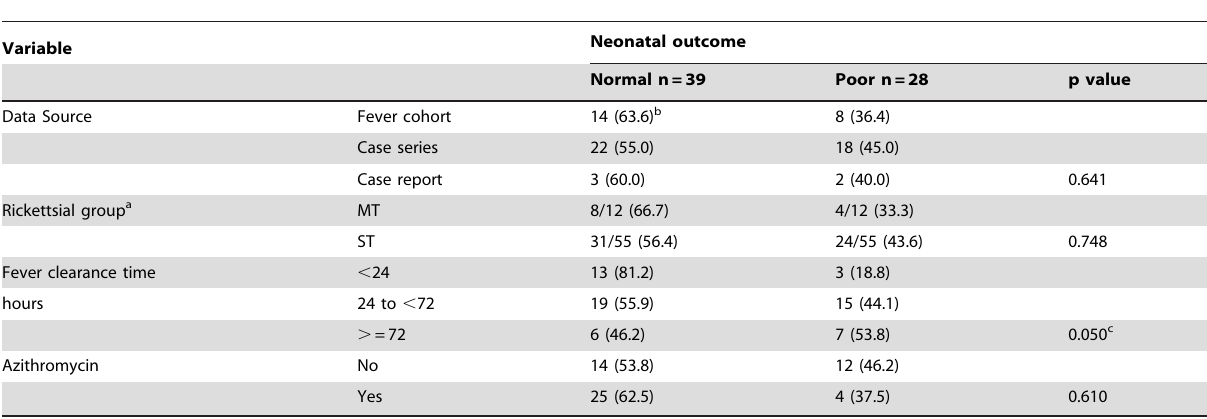
Table 5. Delivered infants from combined case series according to neonatal